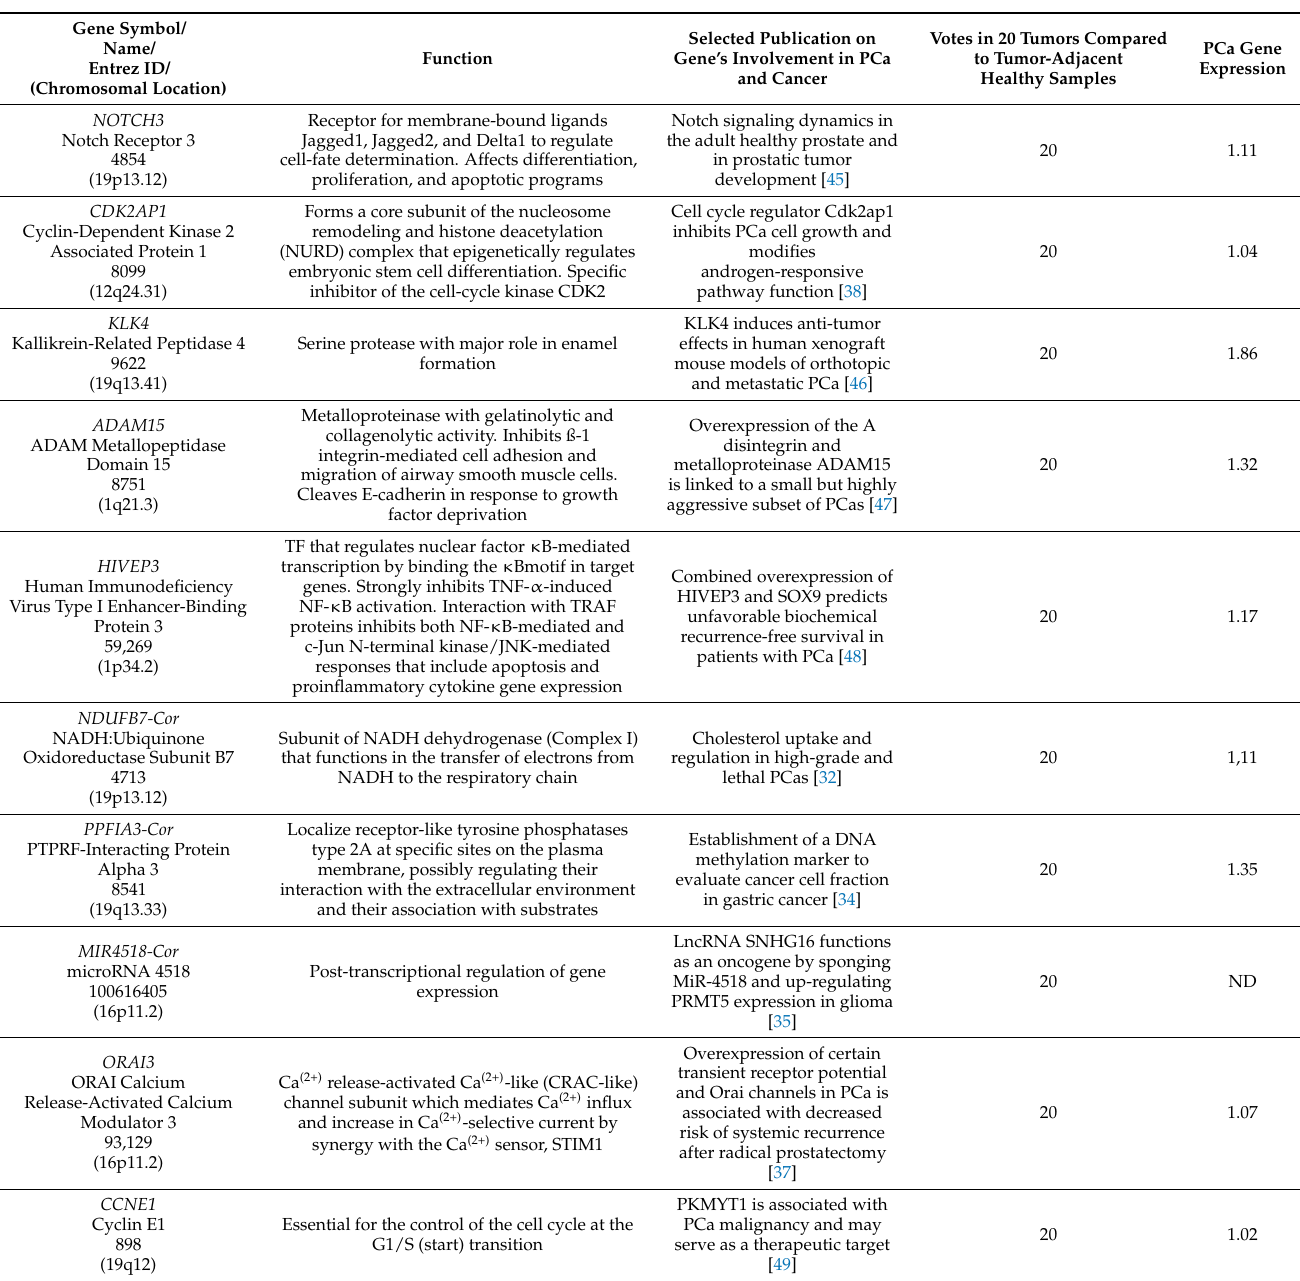
Table 2. Gene-associated CpG-rich probes hypomethylated in PCa. This table presents selected genes which were found associated with hypomethylated CpG-enriched probes in the heat map analyses of hypomethylation presented in Figure 4, right panel. They were selected by consistency of occurrence in all cancer patient samples of the No. 3 cohort and the existing evidence in the literature for their involvement in PCa and cancer in general. The number of votes, calculated by the democratic method, is the number of hypomethylated tumors from 20 tumor samples compared to the average methylation in 8 tumor-adjacent healthy samples. The gene expression in PCa according to The Cancer Genome Atlas (TCGA) PCa expression data bank [23,24] is also